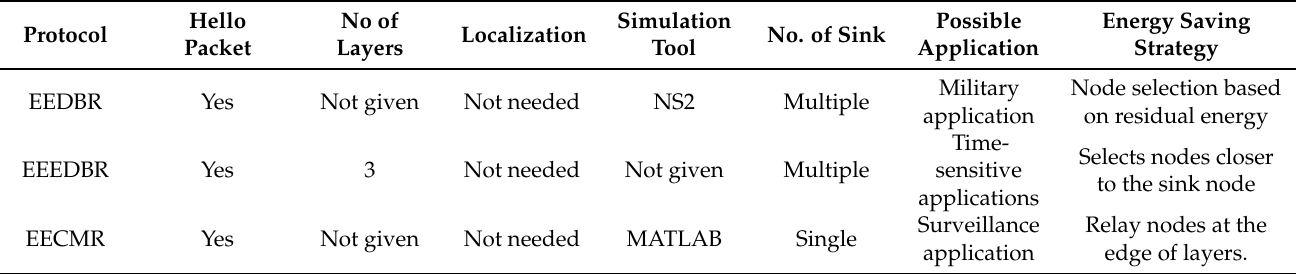
Table 6. Comparison of depth-based routing